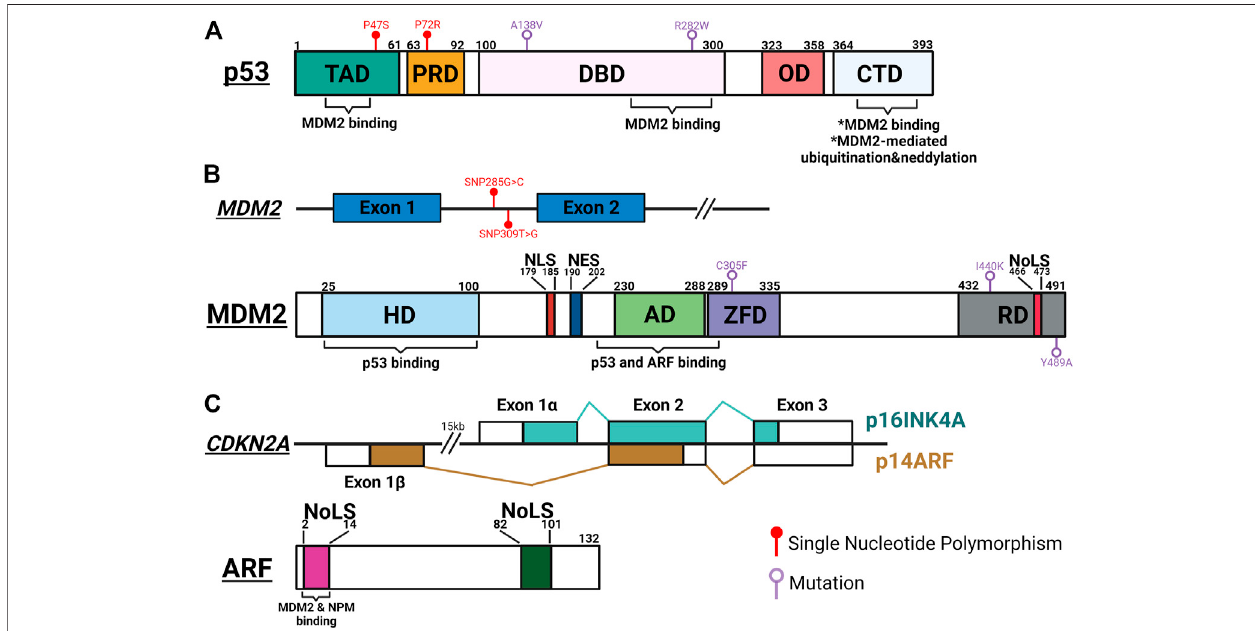
FIGURE1| Schematicsummaryofimportantgeneticandproteinfeaturesofp53,MDM2andARF. (A) p53interactswithMDM2throughitstransactivationdomain (TAD), DNA binding domain (DBD) and carboxy-terminal domain (CTD). MDM2-mediated post-translational modi fi cations occur at the CTD, leading to inactivation and degradation of p53. Single nucleotide polymorphisms (SNP) in TAD (P47S; rs1800371) and proline-rich domain (PRD) (P72R; rs1042522) modulate p53 ’ s ability to suppress tumorigenesis and regulate metabolic fi tness. Temperature sensitive mutations of p53 in DBD (A138V and R282W) result in resistance to MDM2- mediated degradation. OD, oligomerization domain. (B) Upper panel: SNPs of MDM2 regulate the functional oscillation between p53 and MDM2. SNP309T > G (rs2279744) results in higher MDM2 expression and inhibits p53-MDM2 oscillation. SNP285G > C (rs117039649) contributes to lower MDM2 expression and is associatedwithreducedrisksforfemalereproductivecancers.Lowerpanel:MDM2interactswithp53throughitsN-terminalhydrophobicdomain(HD)andaciddomain (AD), andwithARFthroughAD. Interaction withARFexposestheNoLSmotif intheRINGdomain (RD)tosequestertheARF-MDM2complexinthenucleolus.Acancer- associatedsinglemutation,C305F,inthezinc fi ngerdomain(ZFD)mediatesinteractionbetweenMDM2andribosomalproteins(RP)toregulatep53functioninresponse tometabolicstress.TwomutationsinRD (I440K andY489A)reduceMDM2-mediated p53 degradation but still limitp53 activity inresponsetoDNAdamage. (C) Upper panel: The p16INK4A / p14ARF locus. Each transcript utilizing a unique fi rst exon, p16INK4A (Exon 1 α ) and p14ARF (Exon 1 β ) splice into common exon 2 and 3 in alternatereadingframestoproducetwodistinctiveaminoacidsequences,resultingintwounrelatedproteins.Lowerpanel:ARFinteractswithMDM2